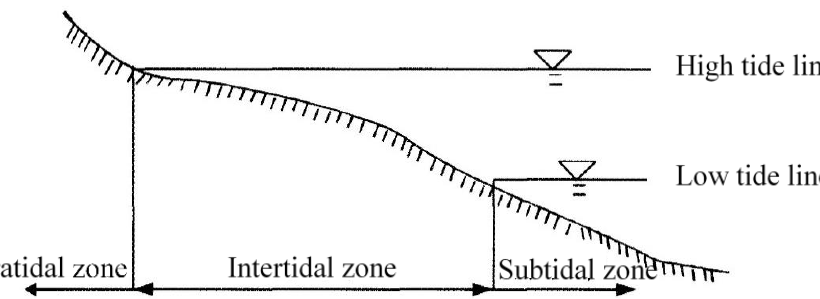
Figure 2. Definition of coastal buffer zone based on marine ecology and environmental science [26].